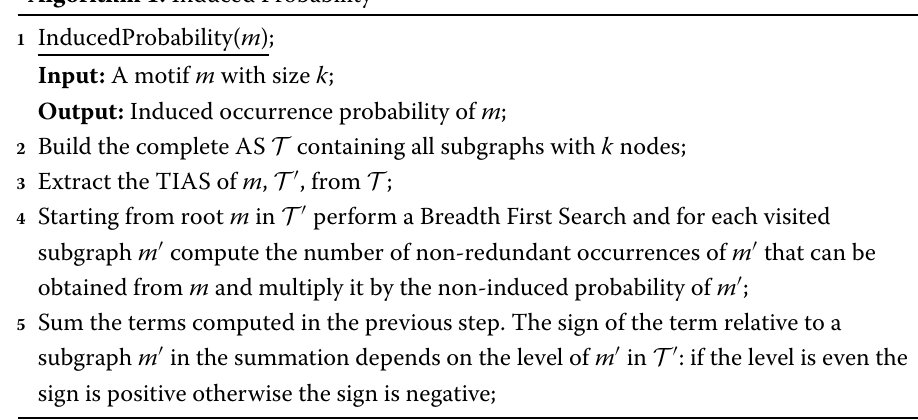
Algorithm 1: Induced